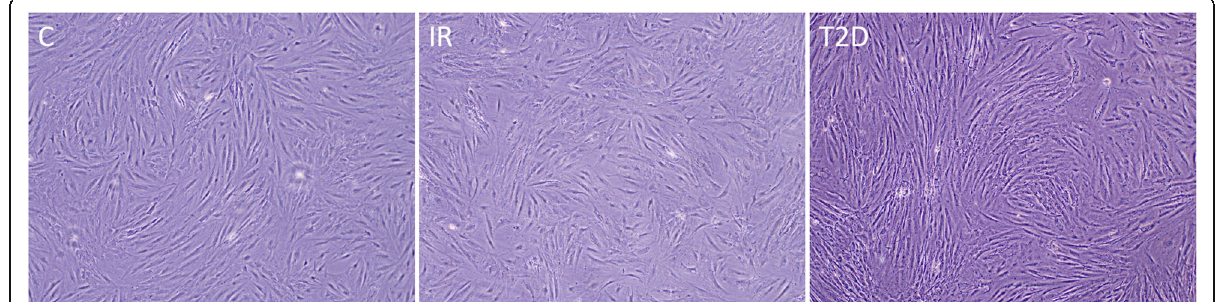
Fig. 4 The morphology of ADSCs from patients with insulin-resistance (IR), type 2 diabetes (T2D) compared to control cells